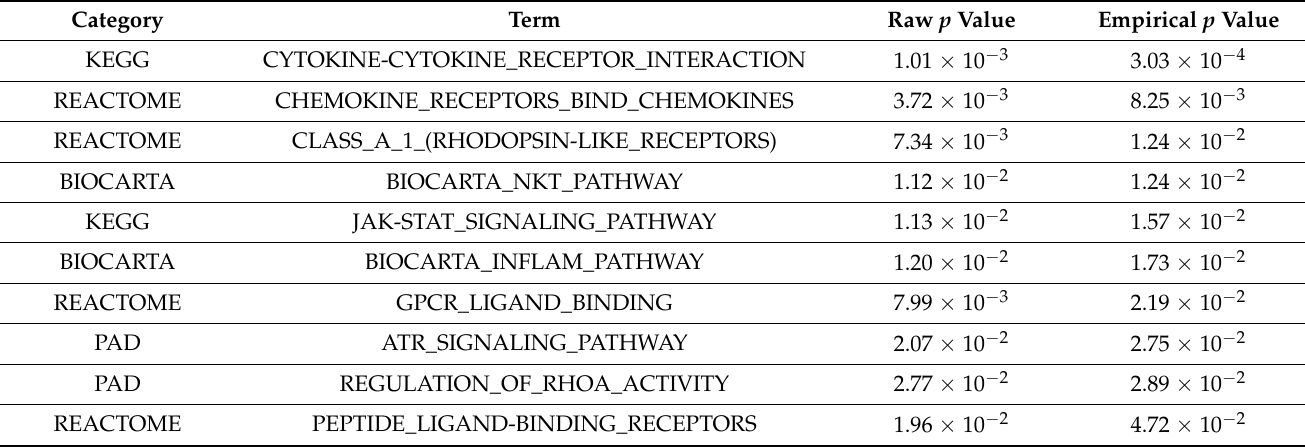
Table 4. Significant terms generated for enrichment analysis performed by miRSystem for top 11 upregulated miRNAs shared among T2DM and IFG female patients while compared to NG subjects. Provided terms were sorted by empirical p value and significantly changed according to both raw and empirical p